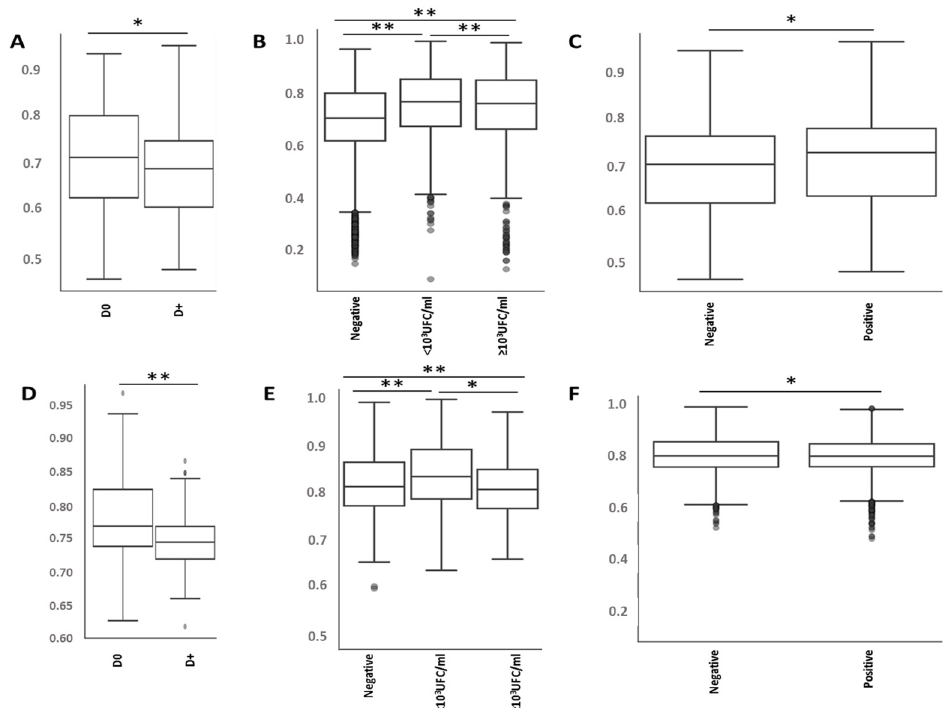
Figure 1. Comparison of alpha-diversities, determined with different indexes (( A ) Simpson; ( B ) Pielou) according to the results of the PVC culture. The box plots represent the mean and inter- quartile range for each index, and the vertical axis is the respective index value.